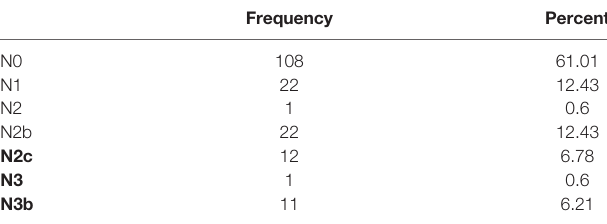
Data are represented as total and relative values, based on n=177